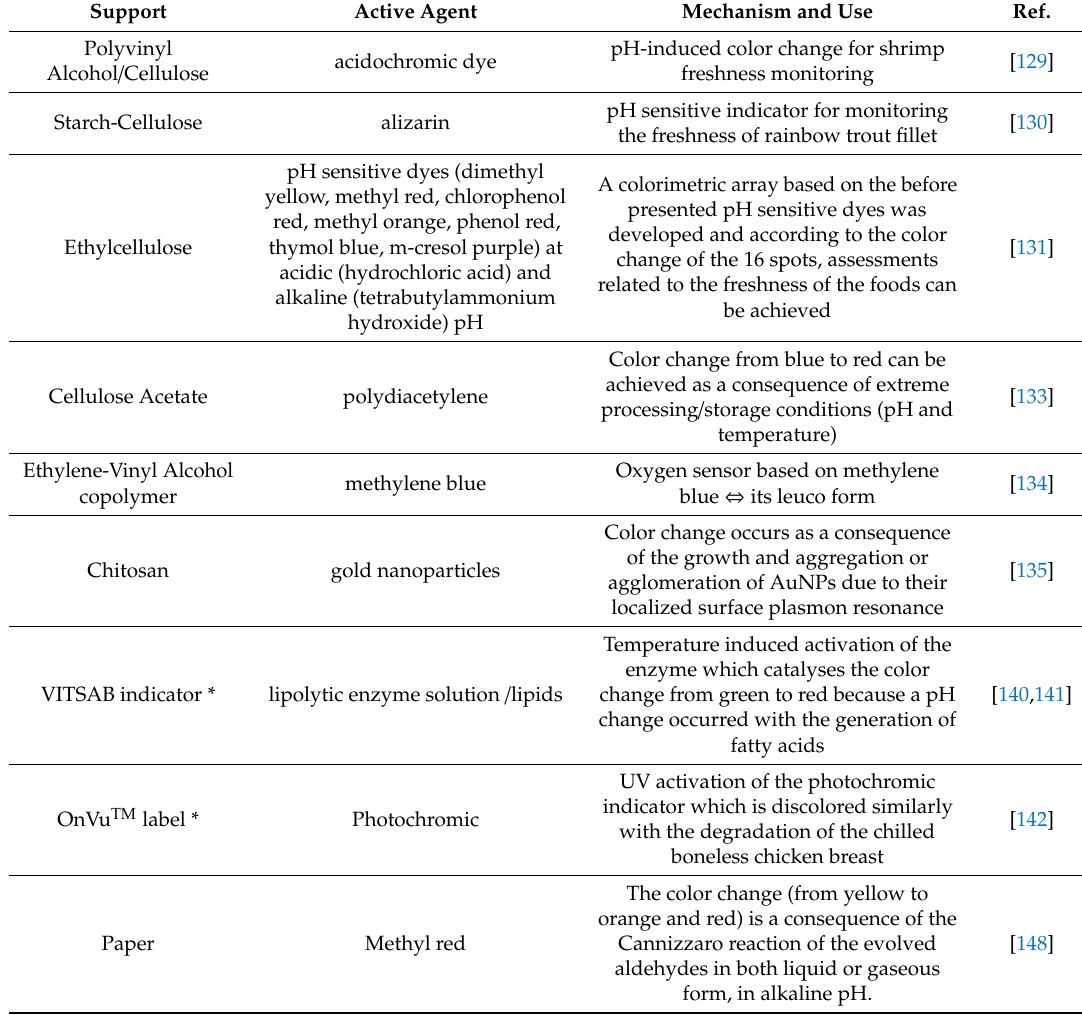
Figure 4. RipeSense TTI label for fruits. Red—Crisp; Orange—Firm; Yellow—Juicy; Green—Expired. Table 3. Real-time monitoring by using smart food packaging.